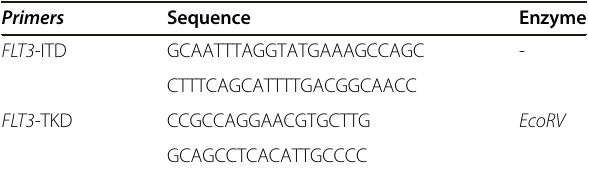
Table 2 Sequence of p rimers and enzymes used in FLT3